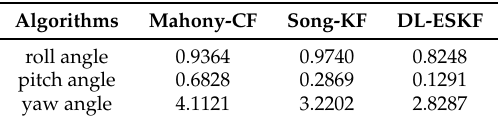
Figure 10. Yaw angle under static conditions. Mahony-CF, Song-KF, and DL-ESKF attitude RMSE (degree) comparison under static conditions.